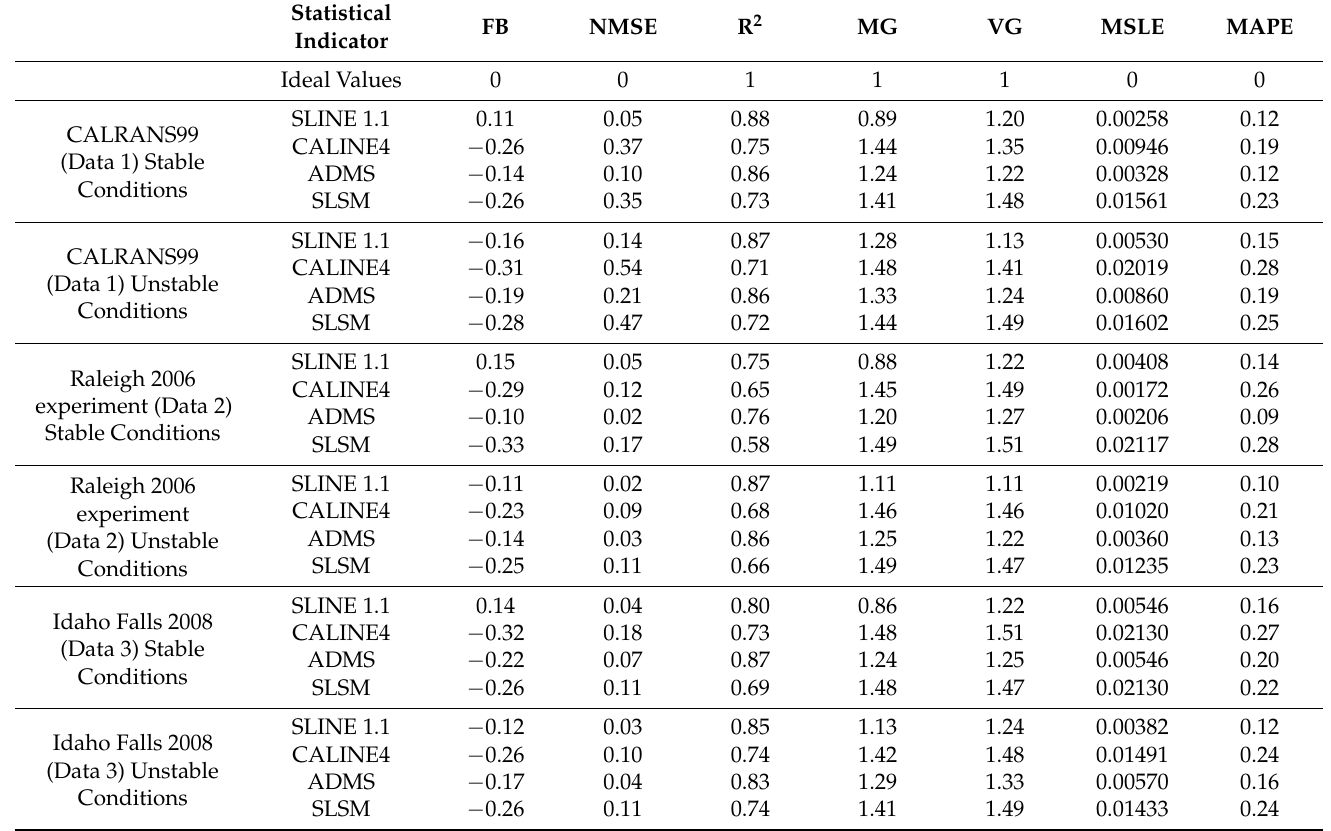
(FB—Fractional Bias, NMSE—Normalized Mean Square Error, R 2 —Coefficient of determination, MG—Geometric Mean Bias, VG—Geometric Mean-Variance, MSLE—Mean Square Logarithmic Error, MAPE—Mean Absolute Percentage